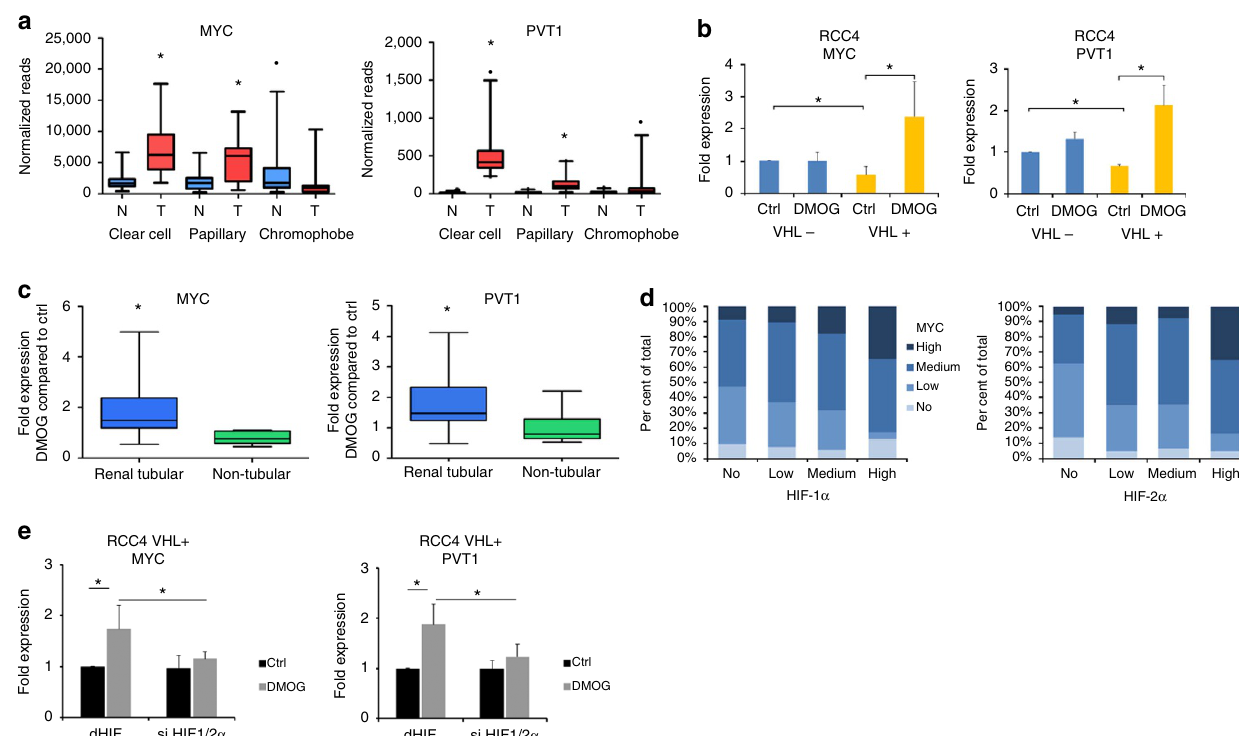
Figure 1 | MYC and PVT1 regulation in renal cancer. ( a ) Analyses of TCGA renal cancer data sets indicate significant overexpression of MYC and PVT1 RNA in clear cell and papillary RCC. Box-and-whisker plots of normalized RNA-seq reads from matching normal (N) and tumour tissue (T) in clear cell ( n ¼ 22), papillary ( n ¼ 31) and chromophobe ( n ¼ 25) RCC. Horizontal lines represent medians, whiskers the 5 and 95% percentiles and dots outliers. *Paired t -test, P o 0.0001. ( b ) MYC and PVT1 RNA expression is reduced by pVHL re-expression in RCC4 renal cancer cells. HIF stabilization by DMOG induces expression of both genes specifically in RCC4 pVHL re-expressing cells. RCC4 cells with defective (blue) or functional (yellow) pVHL were exposed to vehicle or 1mM of the HIF stabilizer DMOG for 16h. n ¼ 3 from independent experiments; values are mean ± s.d., *One-sample t -test, P o 0.05. ( c ) Box-and-whisker plot of relative expression levels (fold change compared to untreated control) of MYC and PVT1 RNA in a collection of 10 pVHL-competent renal tubular derived cells (RCC, primary renal tubular and immortalized renal tubular cells, blue) and 10 non-tubular-derived cells (renal podocytes and non-renal cells, green) exposed to 1mM DMOG for 16h. For details of cell lines, please see Supplementary Fig. 2; horizontal lines represent median values and whiskers show the 5 and 95% percentiles; *Mann–Whitney U -test; P o 0.05. ( d ) MYC protein levels are high in HIF-positive tumours. A total of 330 ccRCC tumours were stratified according to the immunoreactive score for HIF-1 a , HIF-2 a and MYC staining in no, low, medium or strong staining. Fractions of MYC signals are shown for each subgroup for HIF-staining. w 2 -test; P o 0.001 for both HIF-1 a and HIF-2 a . ( e ) MYC and PVT1 RNA expression in HIF- a depleted (si HIF 1 a /2 a , siRNA against HIF1 a /2 a ) or control transfected (si dHIF, siRNA against drosophila HIF) RCC4 pVHL-competent cells exposed to vehicle (ctrl, black) or 1mM DMOG (grey) for 16h. Data present mean ± s.d. from six independent experiments. *One-sample t -test, P o